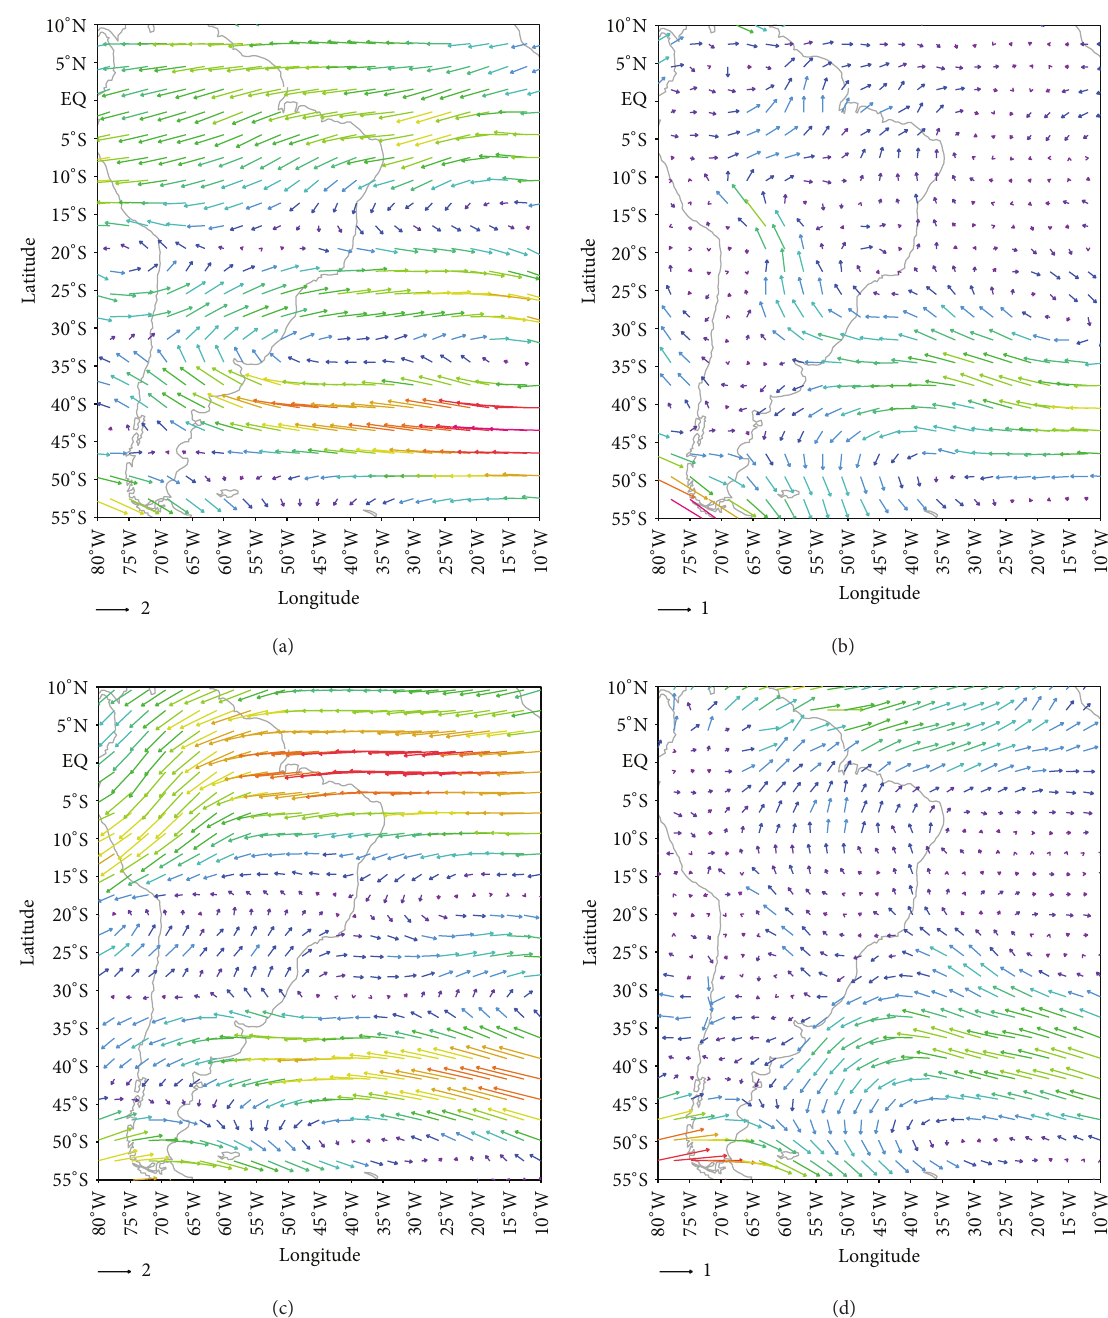
Figure 14: Annual mean horizontal wind (ms −1 ) anomaly for HCSA poleward expansion cases in the period 1996–2011 based on the Era- Interim reanalysis at (a) 200 hPa and (b) 850 hPa and RegCM4 simulation at (c) 200 hPa and (d) 850 hPa. The color scale represents the vector’s